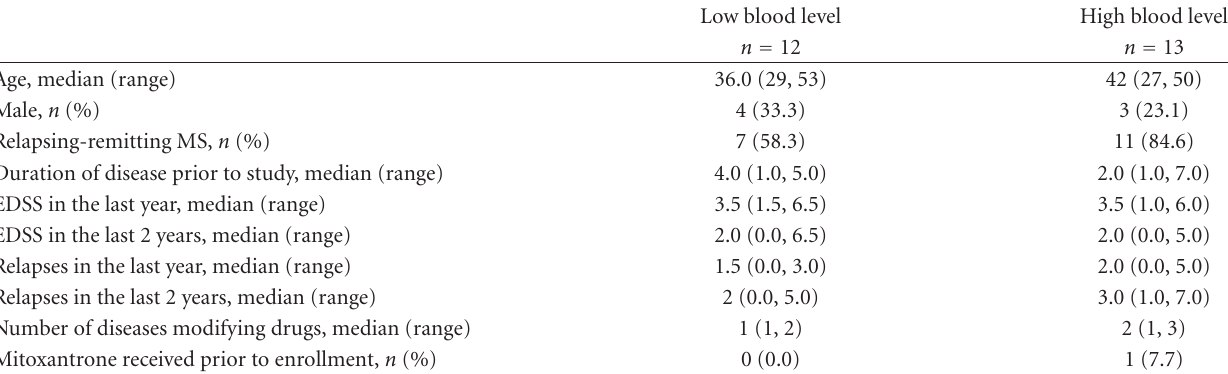
Table 2: Baseline patient characteristics.